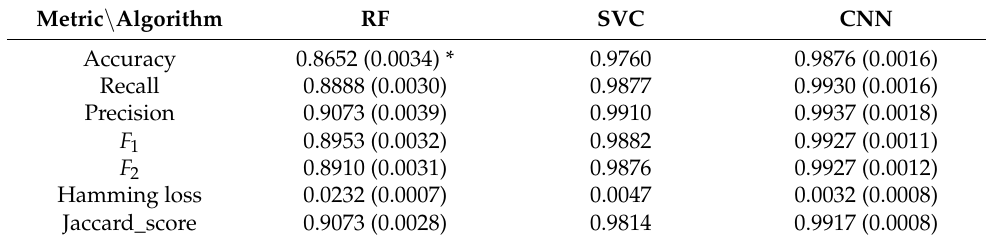
Table 4. Classification performance in experiment